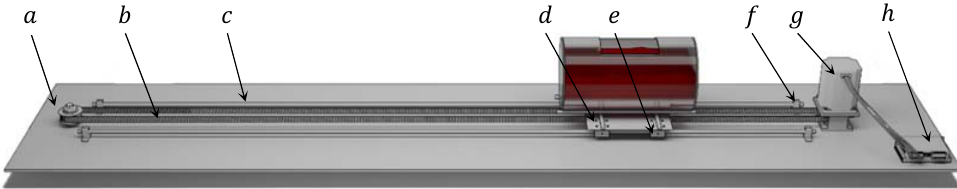
Figure 6. Schematic diagram of the experimental device for sloshing effect study: (a) Pulley, (b) timing belt, (c) sliding rod, (d) tank platform, (e) linear bearing, (f) rod holder, (g) stepper motor (h), and motor controller.